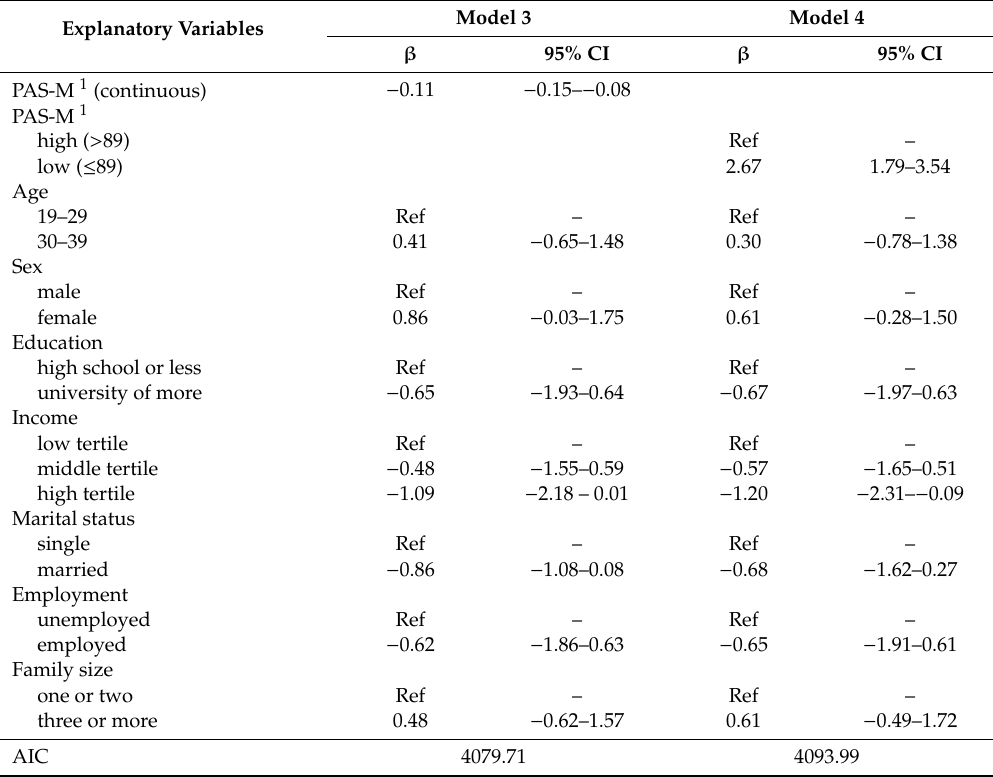
Table 5. Association of owners’ depression symptoms (continuous variable) with the modified Pet Attitude